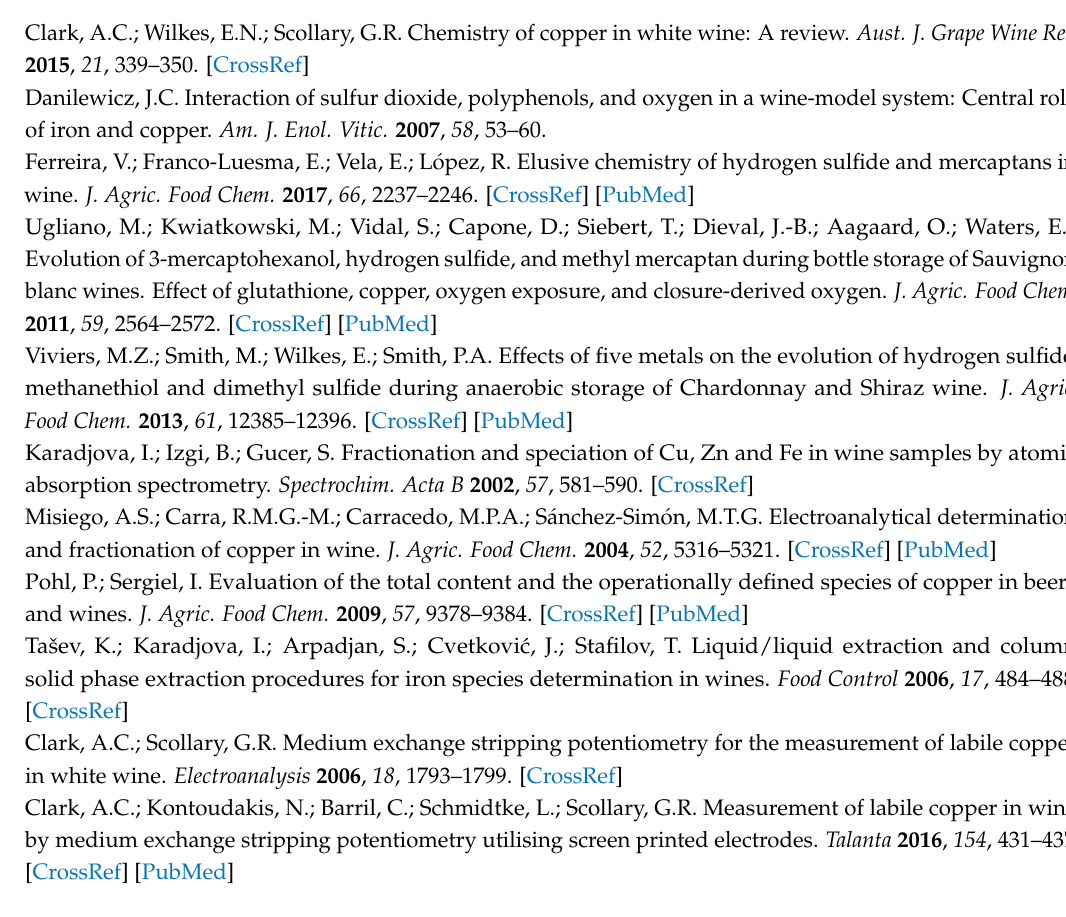
Figure S1: The impact of bubbles on the Cu stripping signal and Cu/Pb stripping ratio during